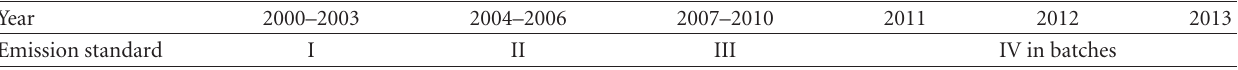
Table 4: Implementation schedule of various Motor Vehicles Emission Standard in China.